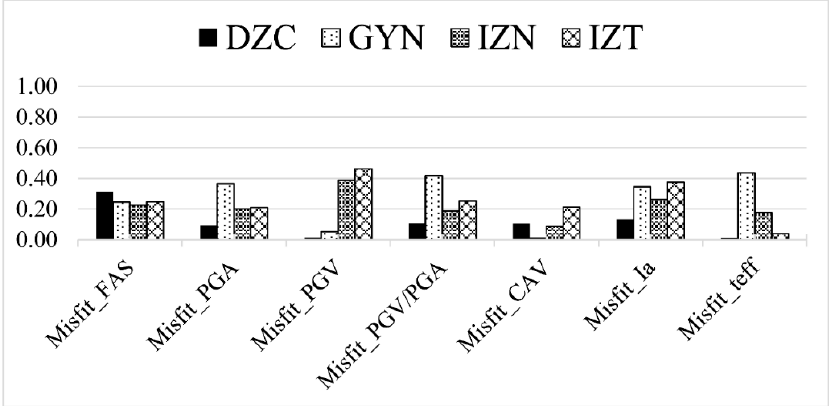
Figure 4. Station-wise seismological log-scale misfits between the real and simulated records of the Erzincan event.